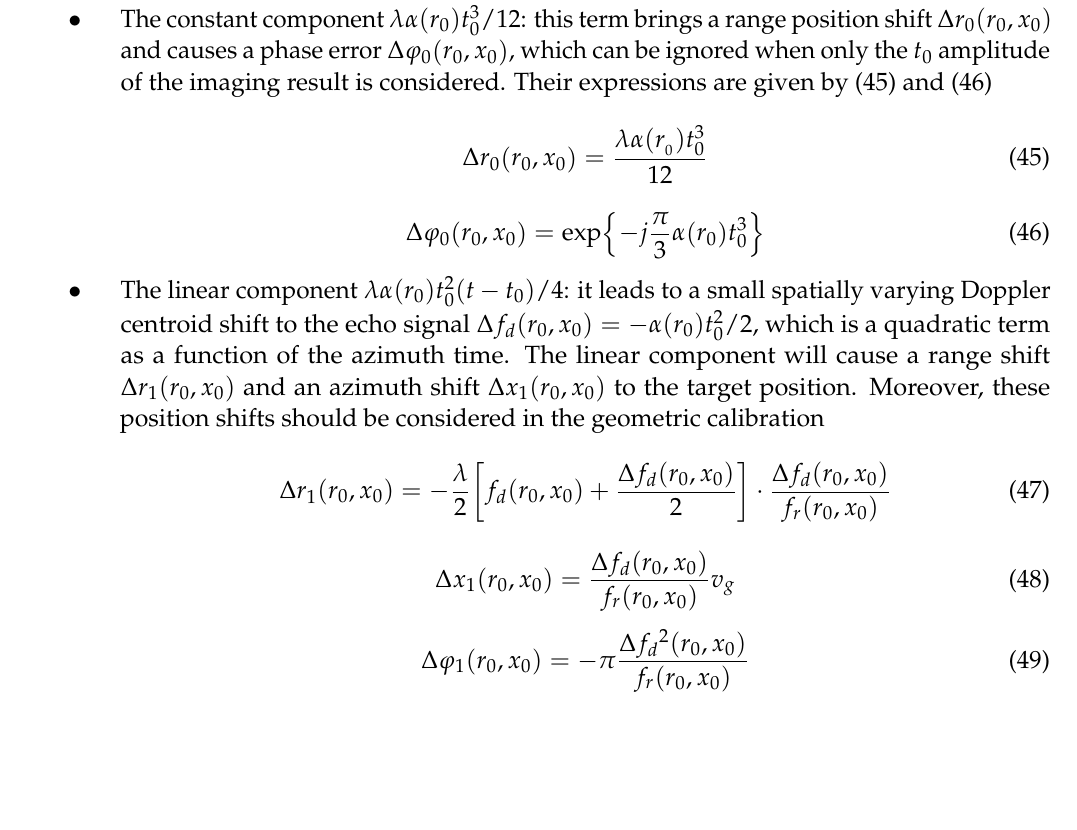
Figure 12. Comparison of computational complexities for the MHCA and the JTDRA. ( a ) The computational complexity of the whole algorithm. ( b ) The computational complexity in dealing with spatial variance.